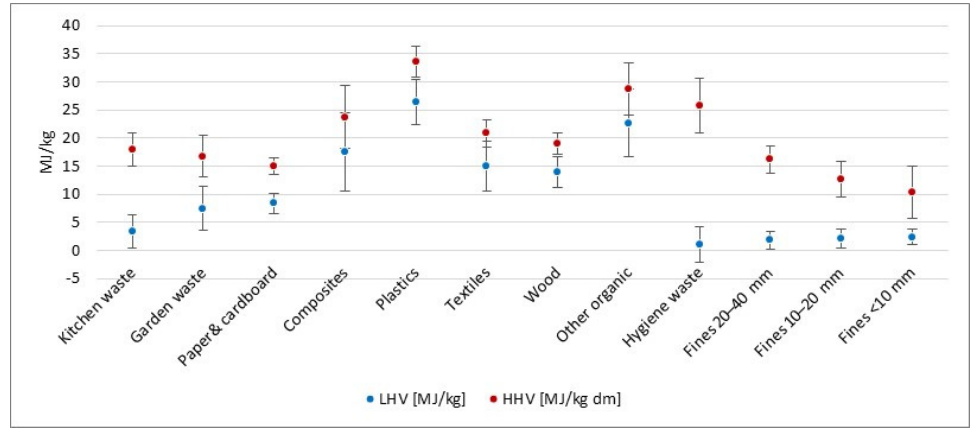
Figure 14. Higher and Lower Heating Values of material fractions contained in residual waste.